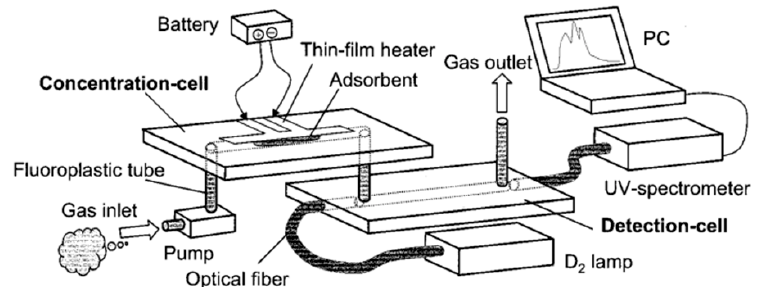
Figure 8. Simplified schematic representation of the device, comprised of a pump, a concentration cell (containing a thin film heater and an adsorbent), a detection cell, and the optical apparatus (UV lamp, optical fiber, and UV spectrometer). The target gas sample is first introduced into the concentration cell. Once inside the concentration cell, the gas is adsorbed on the adsorbent present in the cell. After reaching the desired sample concentration, the temperature of the thin-film heater is raised to approximately 200 ◦ C (by voltage application) in order to desorb the concentrated gas from the adsorbent, which is transferred into the detection cell (this high temperature might be problematic when using for other sensing applications). Reproduced with permission from [18]. Copyright 2001, American Chemical